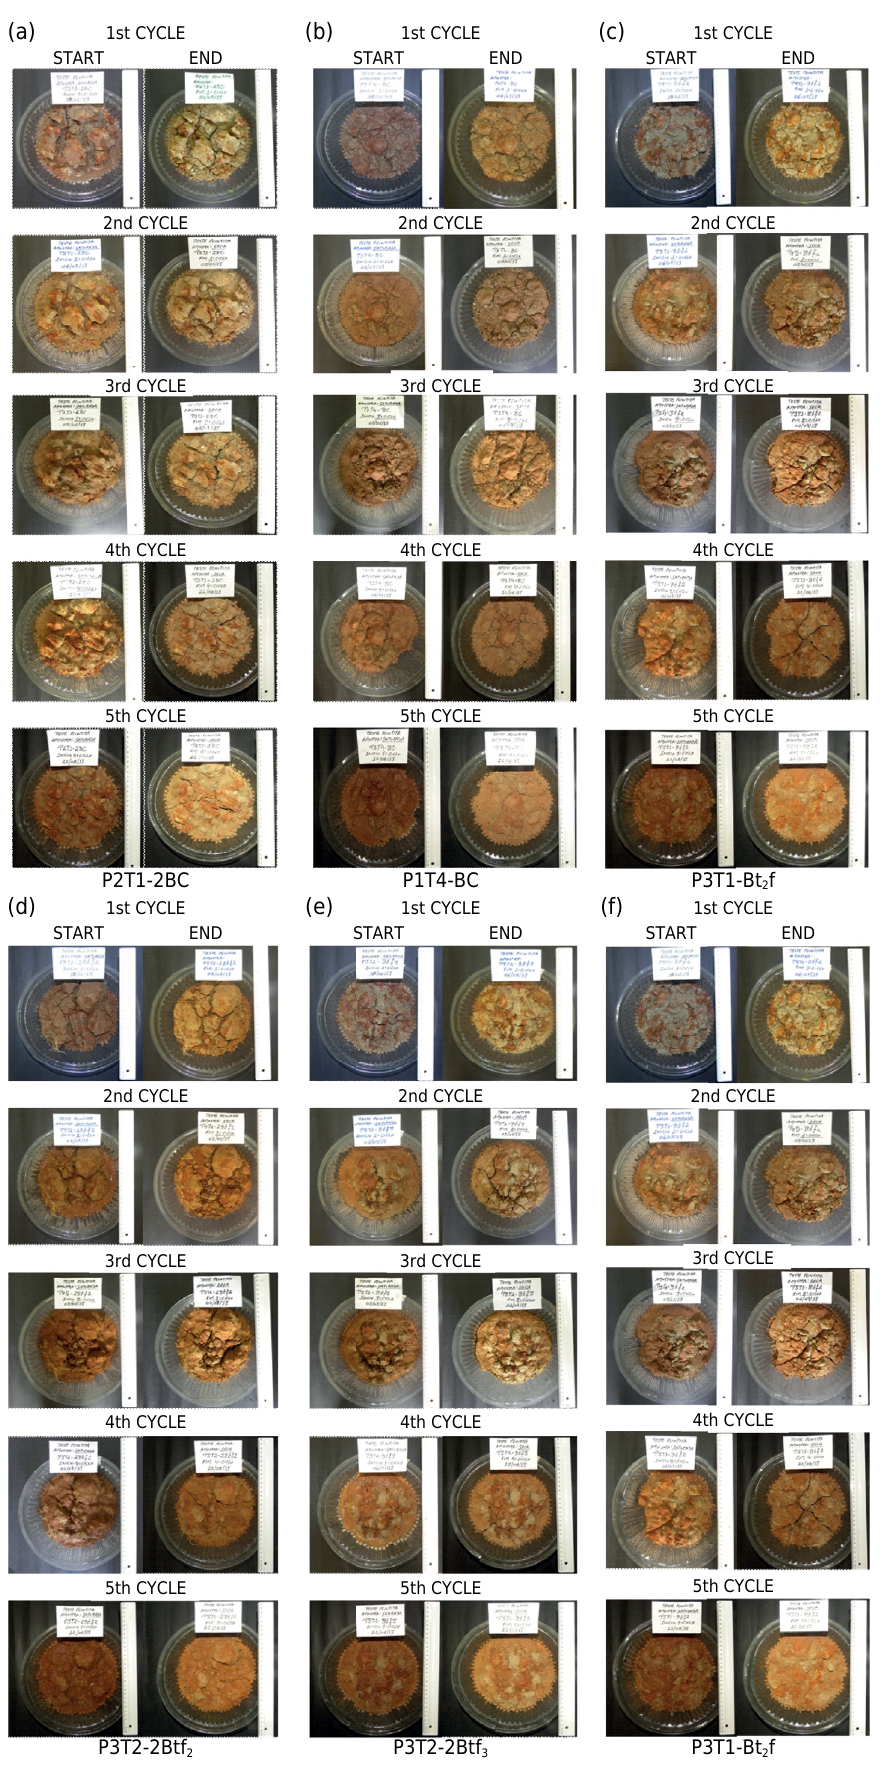
Figure 6. Plinthite visual test result from soil profile horizons submitted to repeated wetting and drying cycles. (a) 2BC-P2T1; (b) BC-P1T4; (c) Bt 2 f-P3T1; (d) 2Btf 2; (e) 2Btf 3 of P3T2; and (f) Bt 2